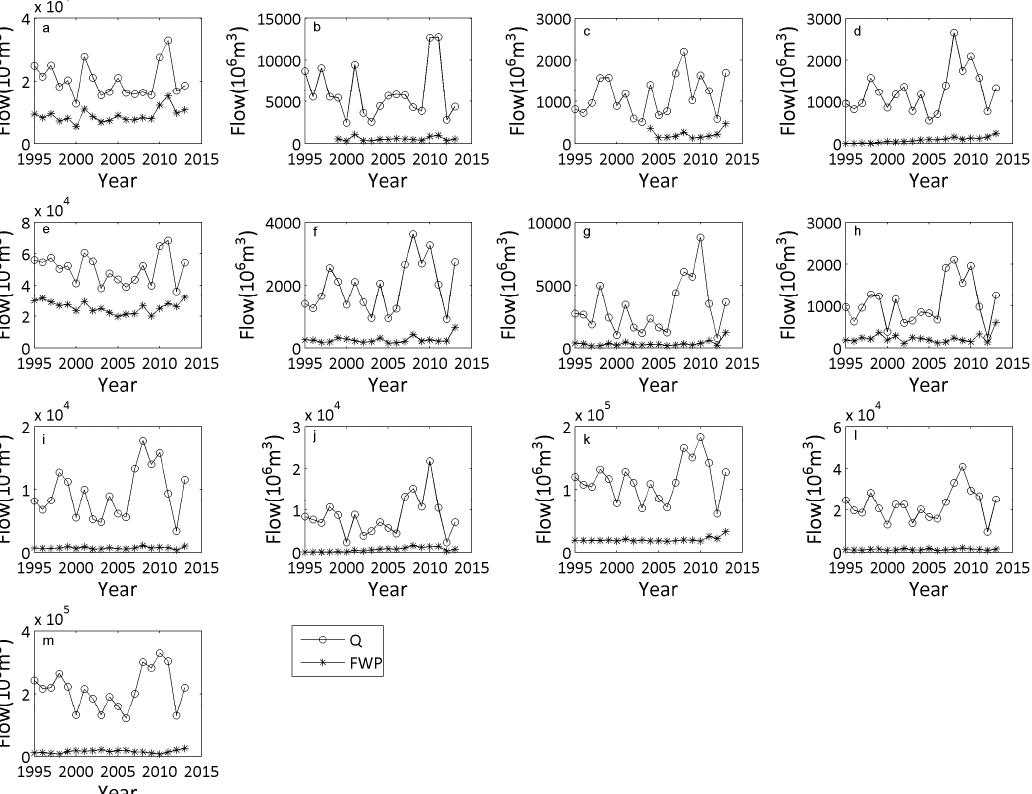
Table 3. Average S r between 1995 and 2013 for MF , MF EF and concentrations of water quality constituents ( C TN , C TP , C TSS ).